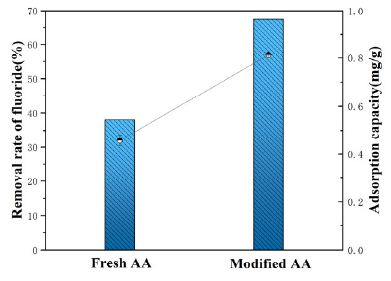
Figure 4. Comparison of fluoride removal effect on fresh AA and MAA. Reaction conditions: [Fluoride concentration] 0 = 8.5 mg/L, [Adsorbent dosage] = 7 g/L, [Reaction time] = 2 h, pH 0 = 4.2 and T = 298 K.